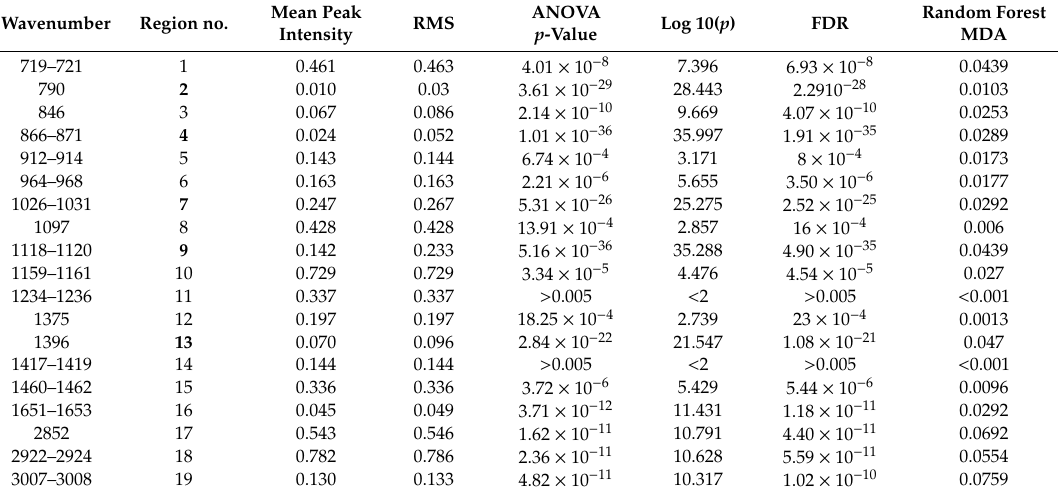
Table 3. The main FT-MIR absorption wavenumbers and regions identified in ATR-FTIR spectra: mean peak intensity values, RMS, ANOVA p -value, log 10( p ), FDR (false discovery rate) and prediction values according to Random forest mean discriminatory accuracy (MDA) values of all samples. Wavenumber Region no.